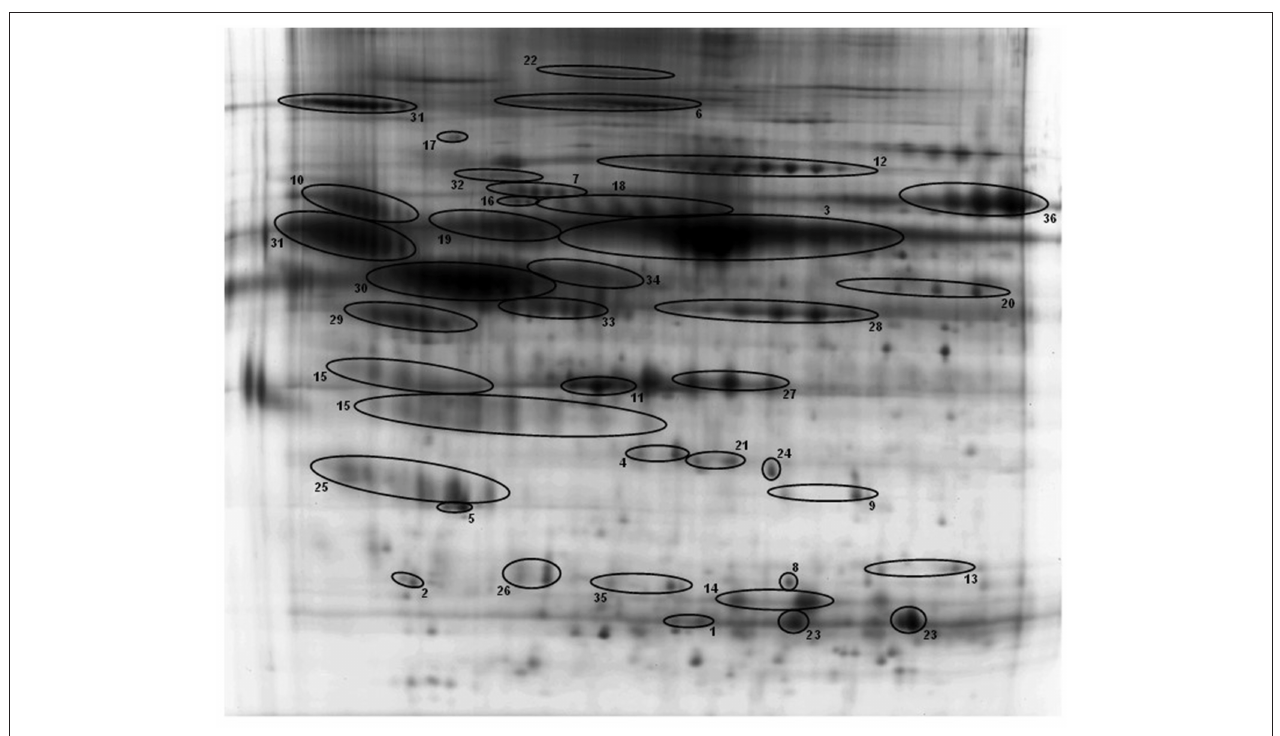
FIGURE 2 | A representative reference gel with identified proteins. Protein spots identified by MALDI-ToF/ToF are circled and numbered, and the names of all the proteins and the corresponding numbers are given in Table 3 . Many proteins have multiple isoforms in the 2-D gel and all isoforms of these proteins are identified and confirmed by